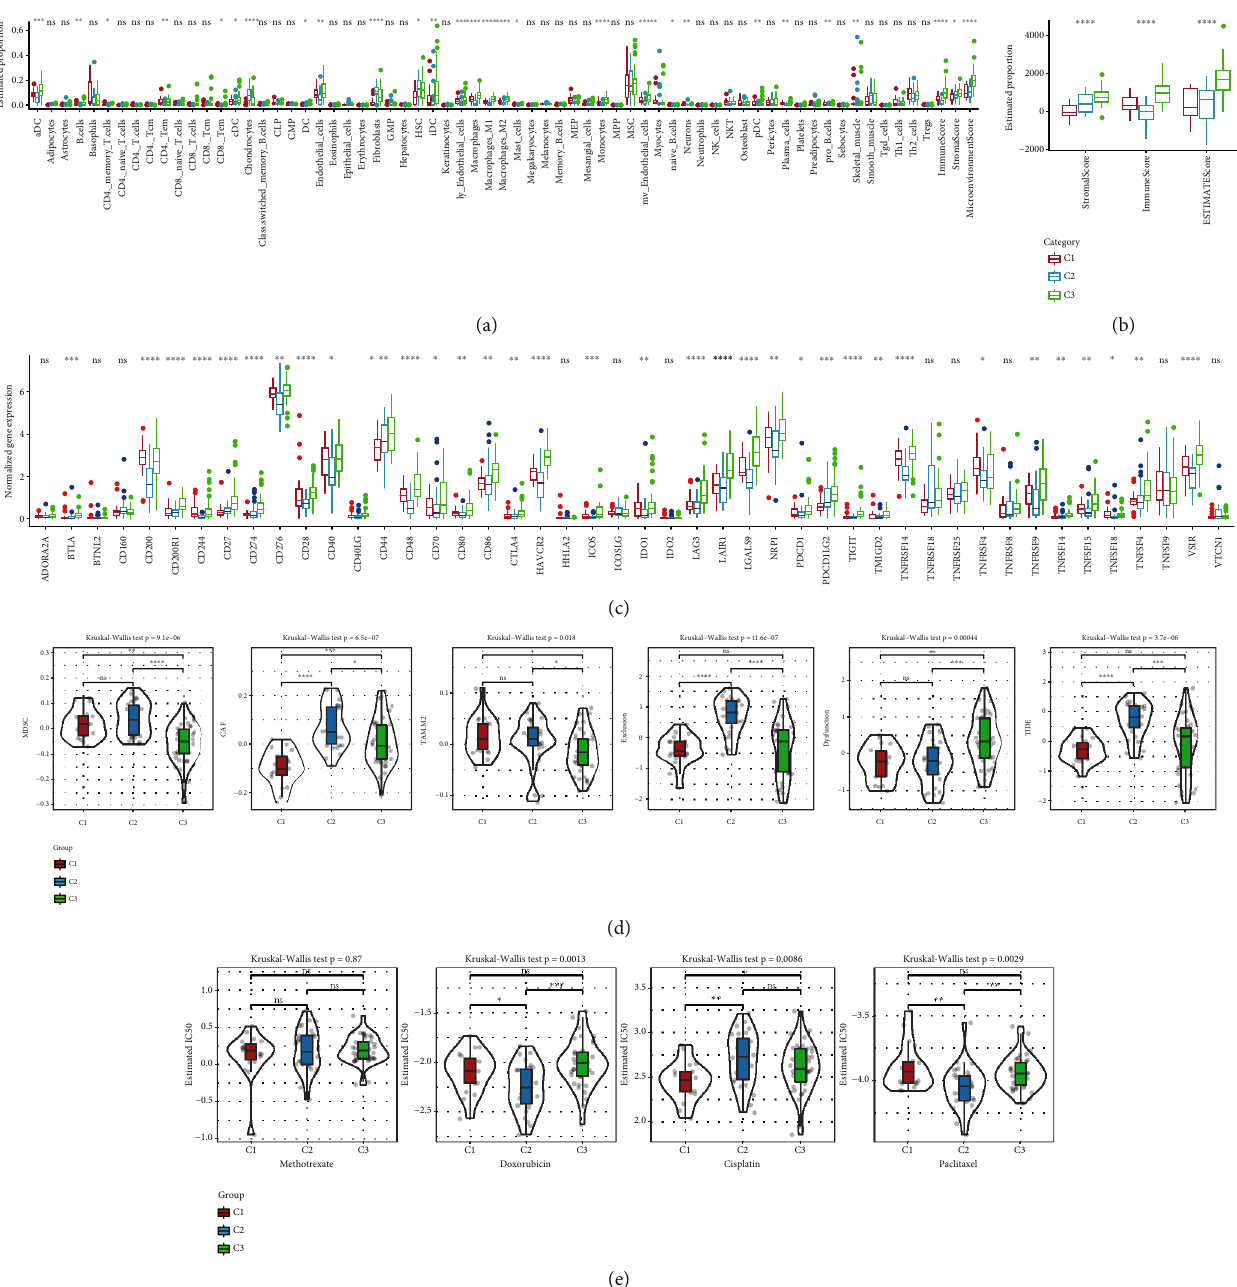
Figure 2: Association of tumor immune in fi ltration and response to immunotherapy and chemotherapy with the molecular subtypes in the TCGA cohort. (a) Di ff erential expression analysis of immune cells. (b) Comparison of stromal score, immune scores, and ESTIMATE scores in patients with di ff erent molecular patterns. (c) Comparison of immune checkpoint-related genes in patients with di ff erent molecular patterns. (d) Comparison of MSDC score, CAF score, TAM.M2 score, T cell exclusion score, T cell dysfunction score, and TIDE score among C1, C2, and C3 subtypes. (e) The sensitivity of patients in di ff erent molecular patterns to methotrexate, cisplatin, cyclopamine, and paclitaxel. ns: no signi fi cance. ∗ P < 0 : 05, ∗∗ P < 0 : 01, ∗∗∗ P < 0 : 001,and ∗∗∗∗ P < 0 : 0001